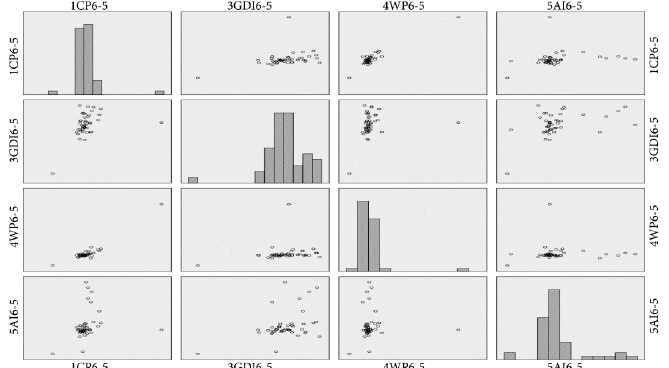
Figure 3. The correlation diagram of the regression variables and of the dependent variable for Model 1 (source: GRETL program)